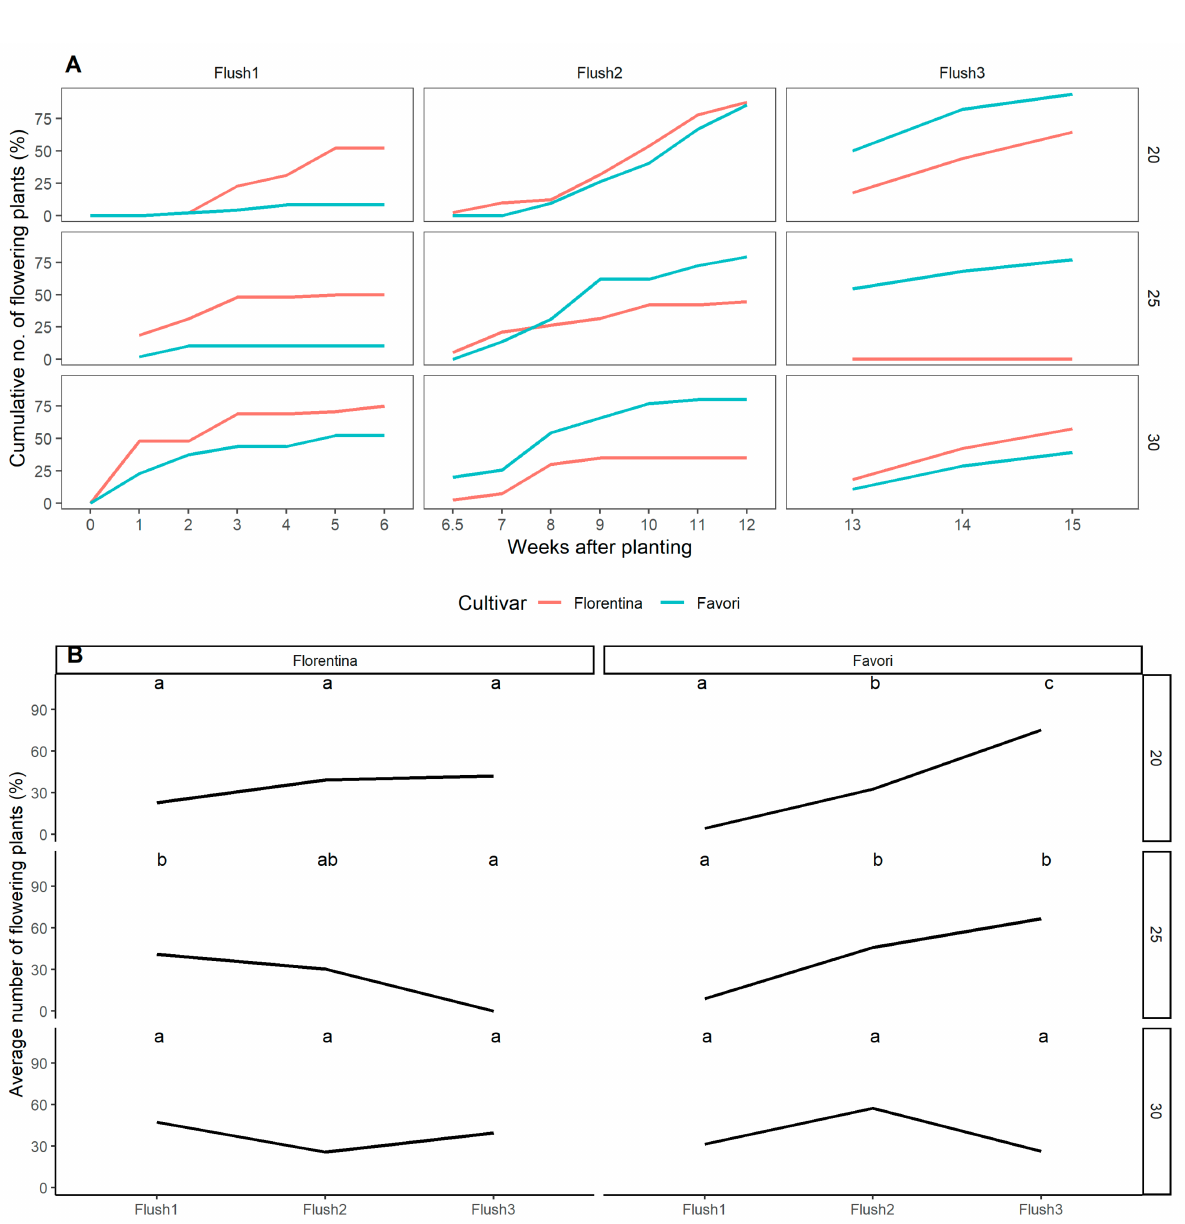
Figure 6. Cumulative number of flowering plants (%), recorded at anthesis, at each flush during the three temperature treat- ments for ‘Florentina’ and ‘Favori’ ( A ). The data was divided into three flushes, where flush 1 = W0–W6, flush 2 = W7–W12, and flush 3 = W13–W15, correlating with the flower mapping data. The number of plants that flushed were compared for each cultivar at each temperature treatment using pairwise comparison and letters were calculated using Tukey’s post-hoc method for multiple comparison. Similar letters indicate no significance at p = 0.05 ( B